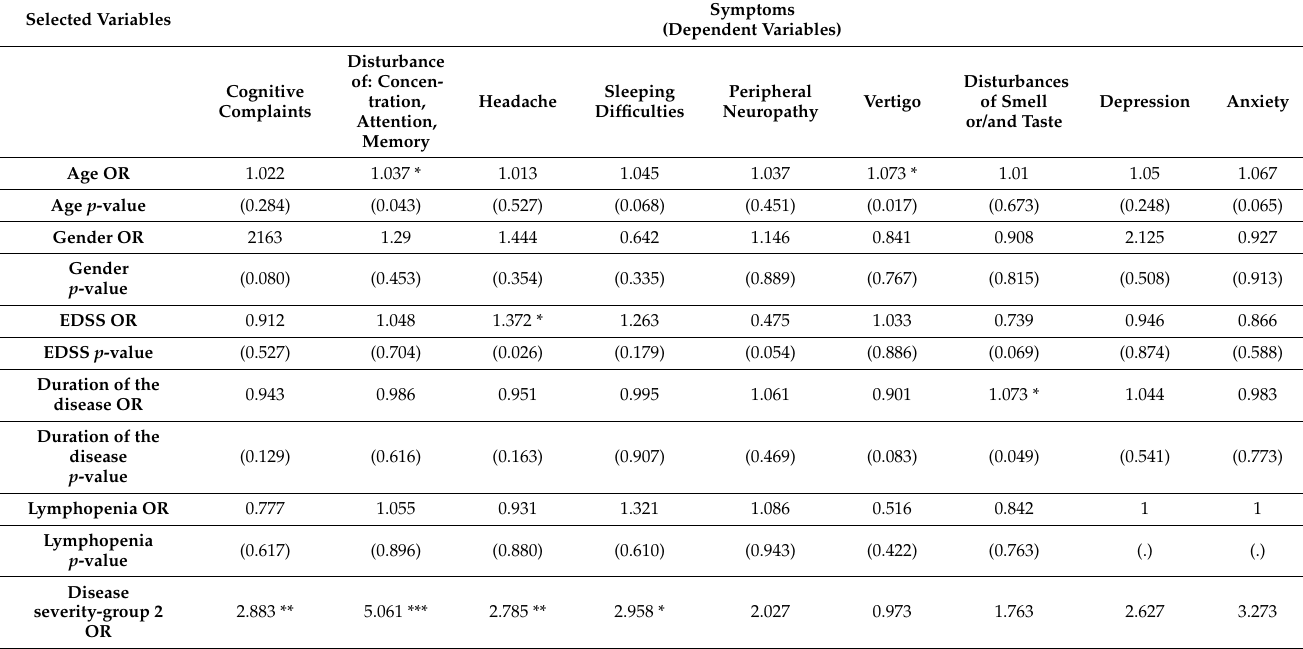
Table 3. Risk factors associated with different neurological symptoms—selected coefficients of logistic regression estimations. Selected